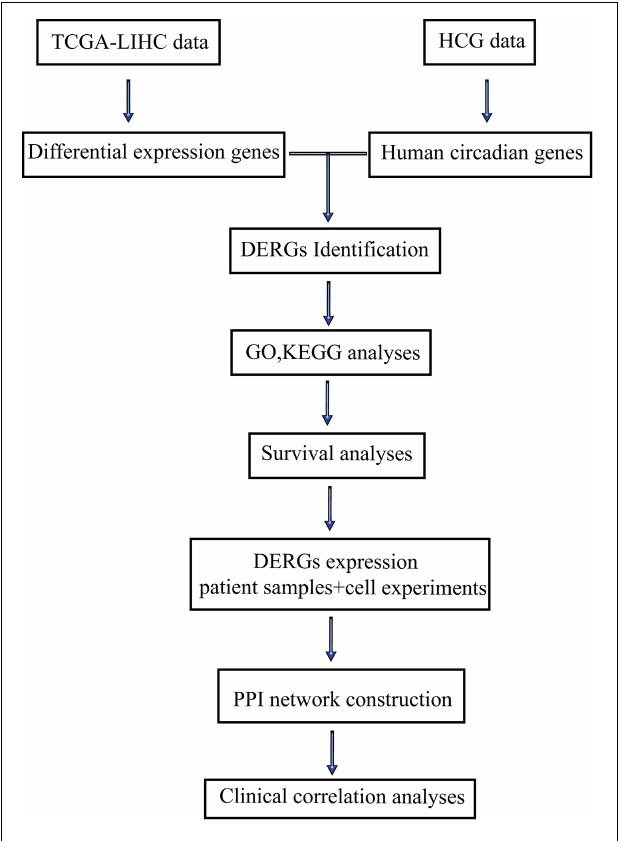
FIGURE 1 | Flow diagram of this